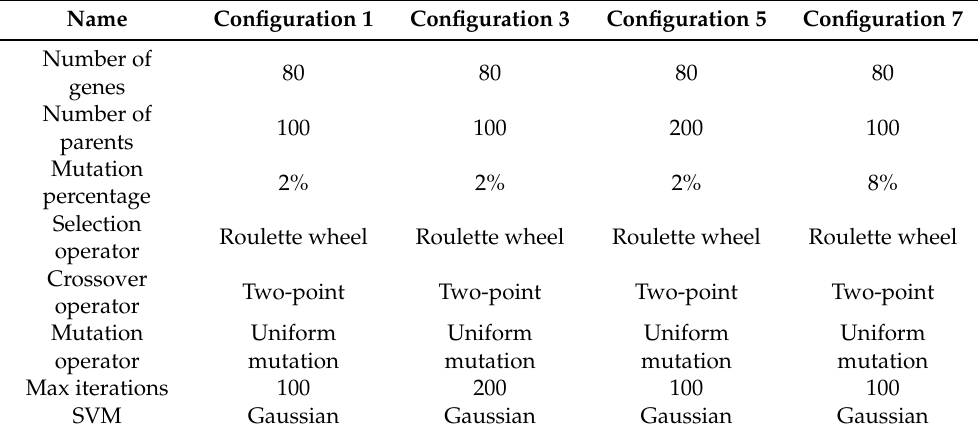
Table 4. Initial parameters used for the genetic algorithms for experiments with Gaussian kernel.